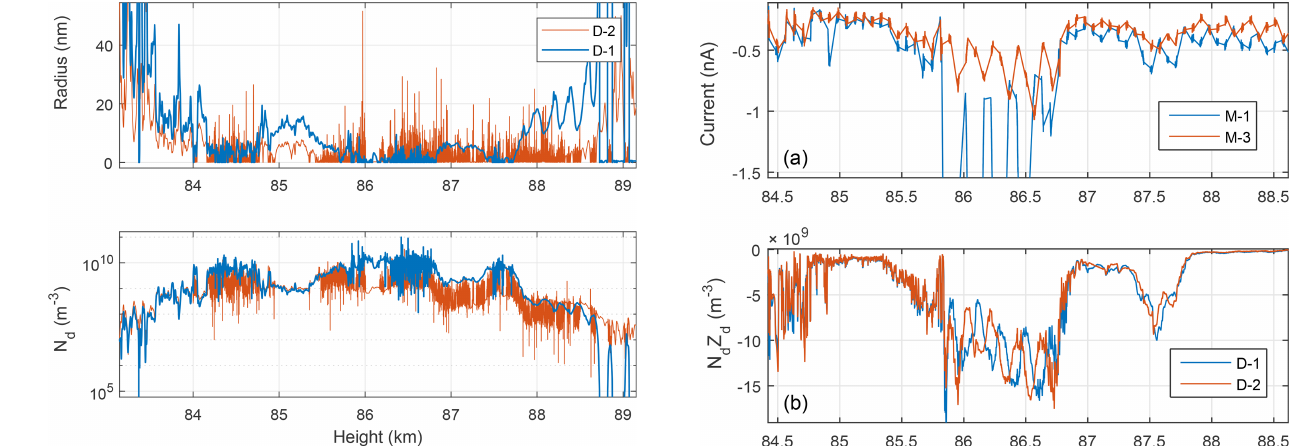
Figure 7. Particle radius and number densities derived from DUSTY-1 (blue) and DUSTY-2 (red) data through the method in- troduced by Havnes et al. (2018). The sizes are generally small and densities are generally high compared to earlier flights and values usually found in lidar studies.